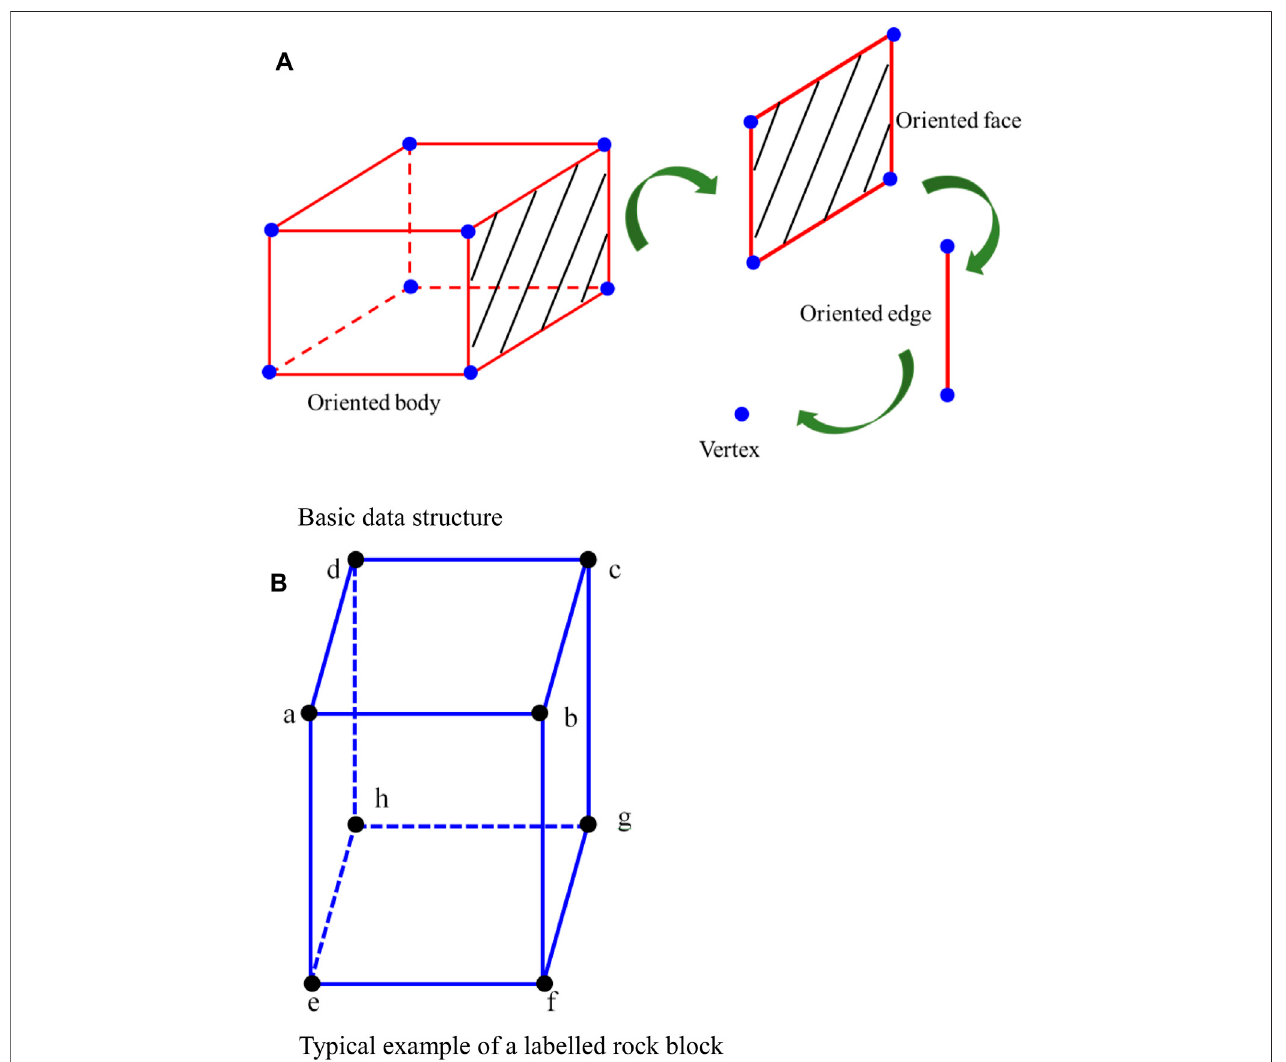
FIGURE 5 | (A) Basic data structure. (B) Typical example of a labeled rock block topological representation of a rock block.